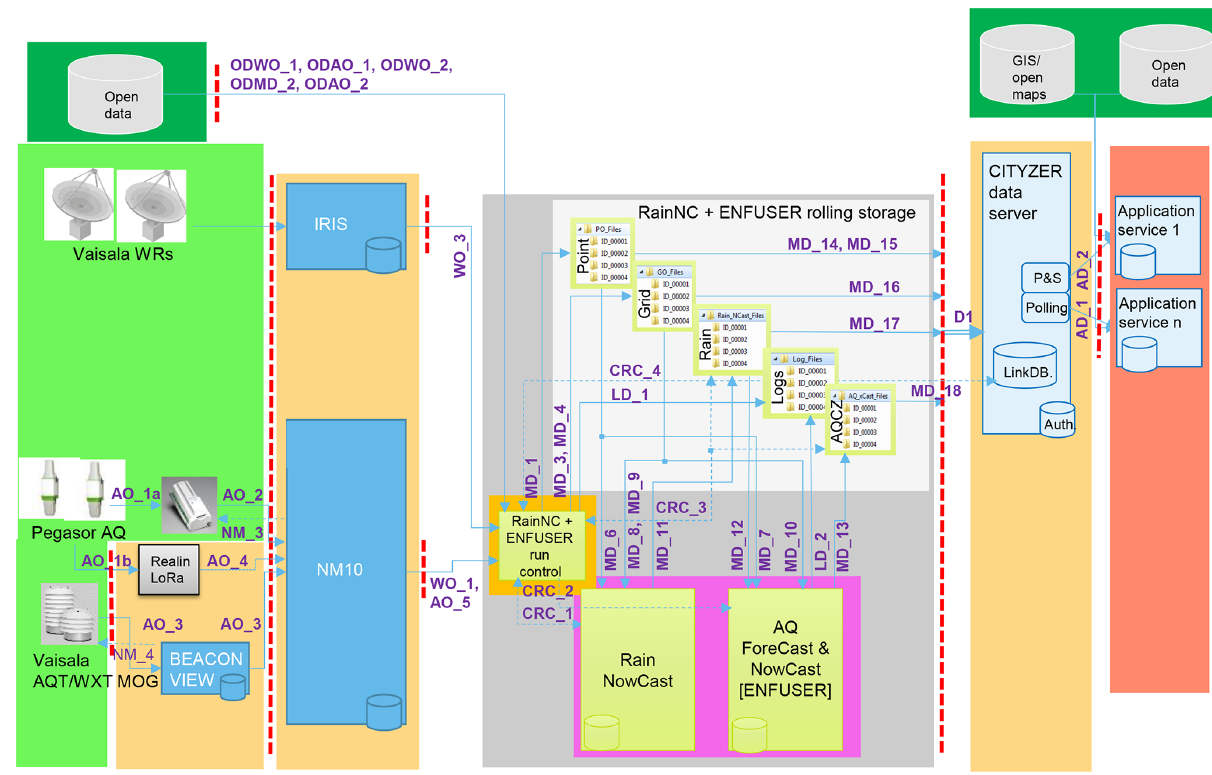
Figure 3. CITYZER demo deployment